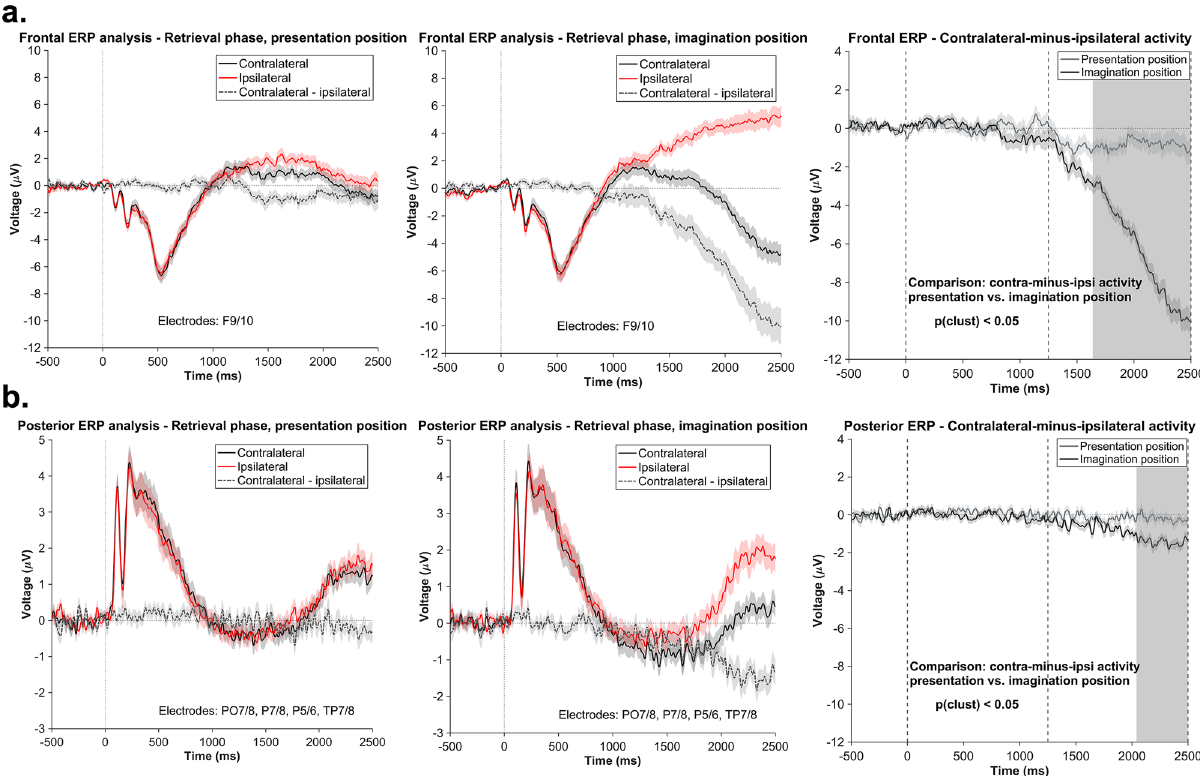
Figure 7. Results of the ERP analysis–retrieval phase. The shaded area represents the standard error of the mean activity. a. Time course of the contralateral, ipsilateral, and contralateral-minus-ipsilateral frontal ERP activity relative to the presentation position (left) and to the imagination position (middle). The right panel depicts the comparison of the frontal contralateral-minus-ipsilateral ERP activity between the two conditions. The gray area marks the significant cluster ( p < .05) obtained as a results of the cluster-based permutation procedure. The statistical testing was conducted separately for two time windows: 0–1250 ms and 1250– 2500 ms, as indicated by the gray dotted lines. b. Time course of the contralateral, ipsilateral, and contralateral- minus-ipsilateral posterior ERP activity relative to the presentation position (left) and to the imagination position (middle). The right panel depicts the comparison of the posterior contralateral-minus-ipsilateral ERP activity between the two conditions. The gray area marks the significant cluster ( p < .05) obtained as a results of the cluster-based permutation procedure. The statistical testing was conducted separately for two time windows: 0–1250 ms and 1250–2500 ms, as indicated by the gray dotted